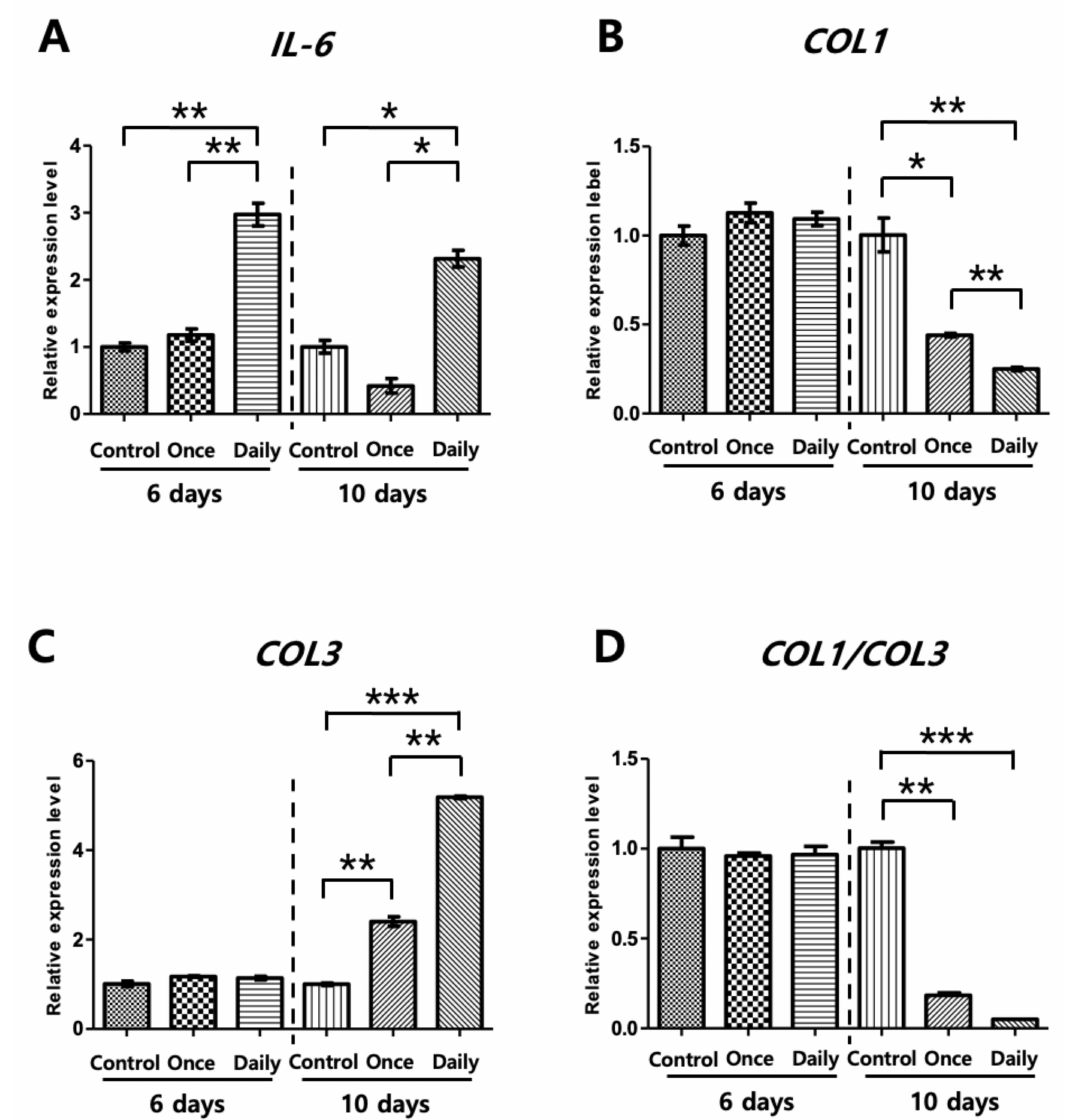
Figure 2. Quantitative real-time polymerase chain reaction (qRT-PCR) evaluation at 6 and 10 days of cell culture. To evaluate the inflammatory response and gene expression of collagen type 1 ( Col1 ) and collagen type 3 ( Col3 ), quantitative real-time polymerase chain reaction (qRT-PCR) was conducted on day 6 and day 10 of cell culture. The Daily group showed a significant increase in IL-6 expression, a proinflammatory cytokine gene. ( A ) Col3 expression was increased by substance P (SP); however, expression of Col1 was decreased 10 days after Daily SP treatment. The Col1 / Col3 ratio decreased significantly in all experimental groups ( B – D ). Experiments were performed in triplicate. Control: phosphate-buffered saline injection (no SP treatment), Once: one-time SP treatment on day 0, Daily: daily SP treatment. Data are represented as mean ± standard deviation. Kruskal-Wallis test with Tukey’s post-hoc test was used for statistical evaluation. n = 5. * p < 0.05, ** p < 0.01, *** p < 0.001. Biomechanical testing revealed that the N. Control group had a significantly higher (1.88 times) tensile strength than the other groups ( p < 0.05 or 0.01). However, there were no significant di ff